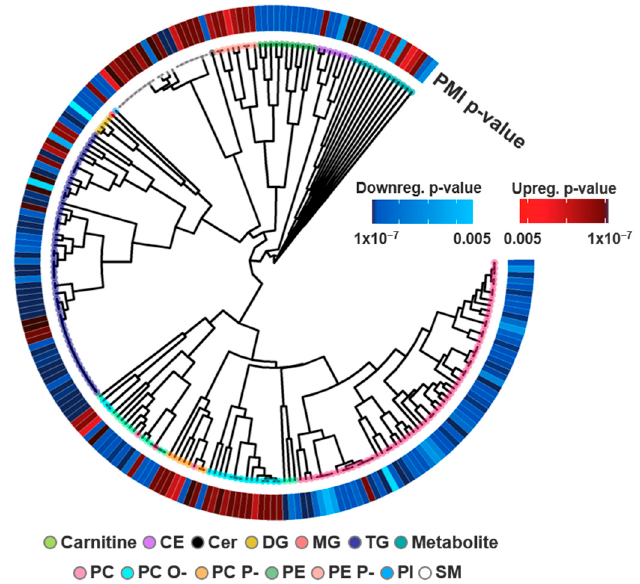
Figure 5. The multi-omic assessment of statistically significant lipids and metabolites from a PMI event. Adjusted p -values for each molecule are shown around the dendrogram. Red and blue are used for up- and downregulation with a color gradient to visualize magnitude.